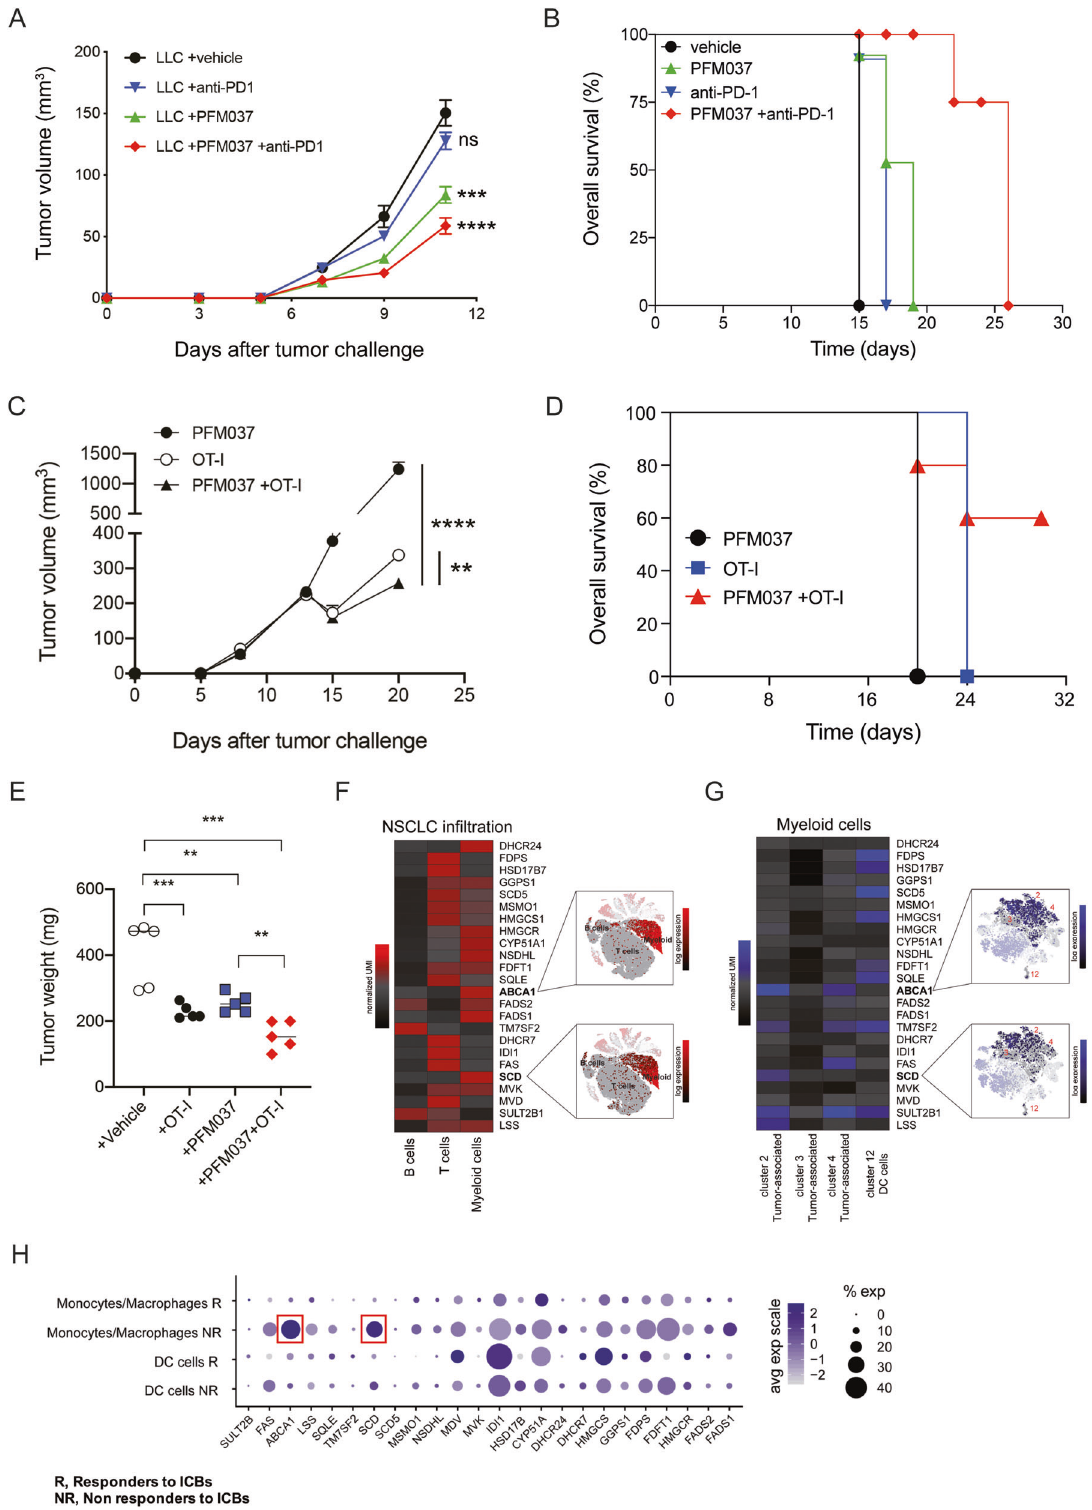
solution of NH 4 Cl (15 mL) was added and the mixture extracted with EtOAc (2 ×15 mL). The combined organic layers were washed with brine (10 mL) and dried over anhydrous Na 2 SO 4 . After the removal of the solvent, the crude product, thus obtained, was puri fi ed by fl ash chromatography (light petroleum/EtOAc, 95:5) affording 2 in 66% yield. 1 H NMR (400MHz, CDCl 3 ) δ 0.43 (s, 1H), 0.65 (s, 1H), 0.73 (s, 3H), 1.87-1.99 (m, 3H), 2.77 (s, 1H), 3.32